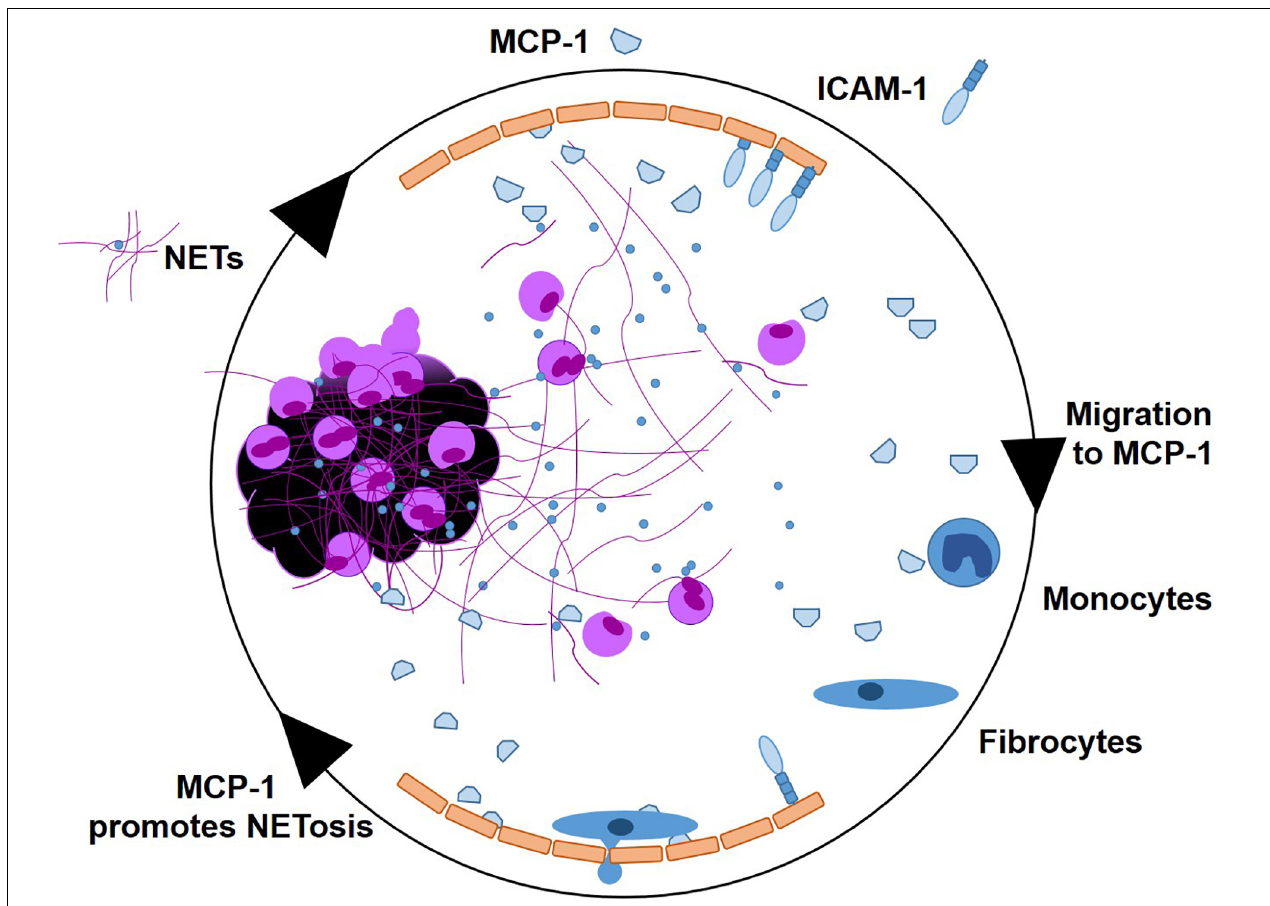
FIGURE 7 | Graphical abstract. NETs as signaling scaffolds at the culprit site of STEMI. MCP-1 and ICAM-1 are expressed by endothelial cells. MCP-1 stimulates further NETosis. Monocytes enter the culprit site along an MCP-1 gradient, to transdifferentiate into fibrocytes in the presence of